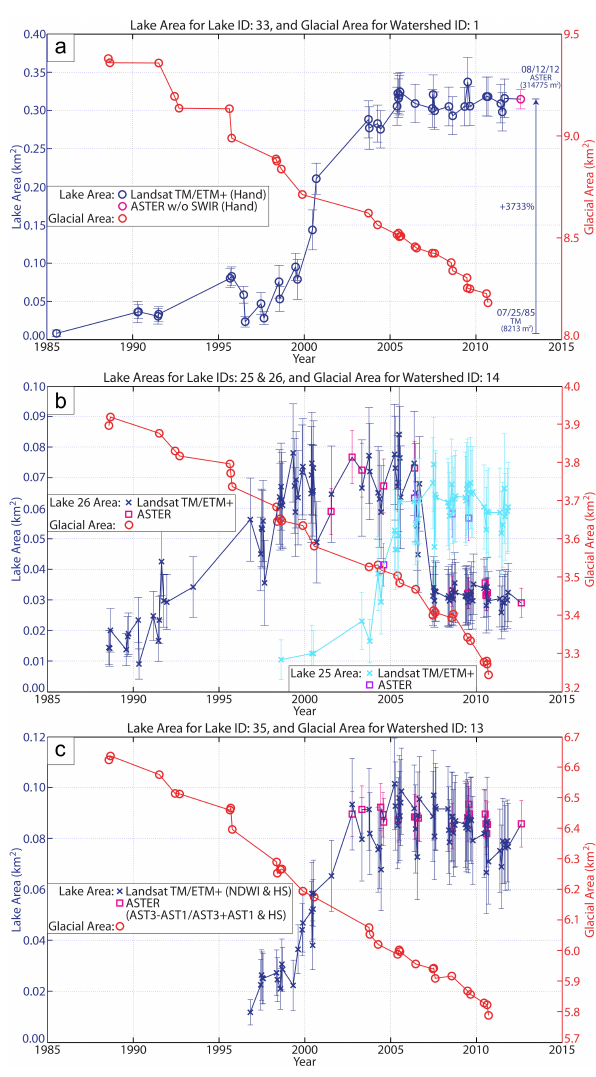
Fig. 12. Lake-area (blue) and glacial-area (red) time series for four proglacial lakes of the western QIC (Glacial ID 1). Locations of each lake and catchment can be found in Fig. 8b. (a) Lake ID 33, a lake in front of Qori Kalis glacier. Note that all area measurements of Lake ID 33 are hand-delineated, as this lake had a spectral sig- nature that was not captured by any of the employed methodology (cf. Fig. 5). (b) Lake IDs 25 and 26, and (c) Lake ID 35. Notice that the majority of lake growth occurred during the late 1990s and early 2000s. We do not show uncertainties in the glacial areas ( ∼ 5%) to avoid cluttering the